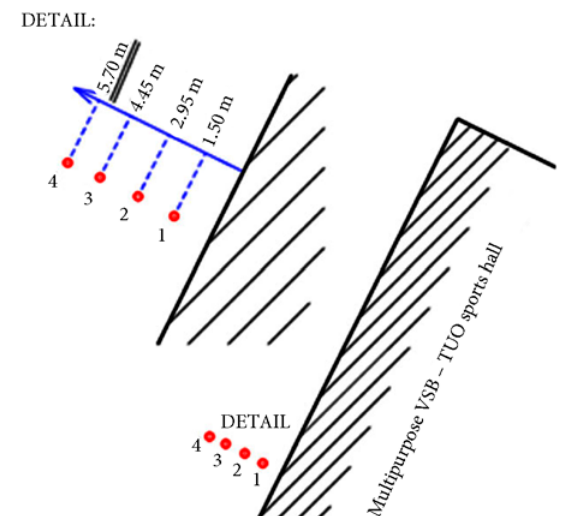
Fig. 3. Observed points – VSB – TUO sports hall